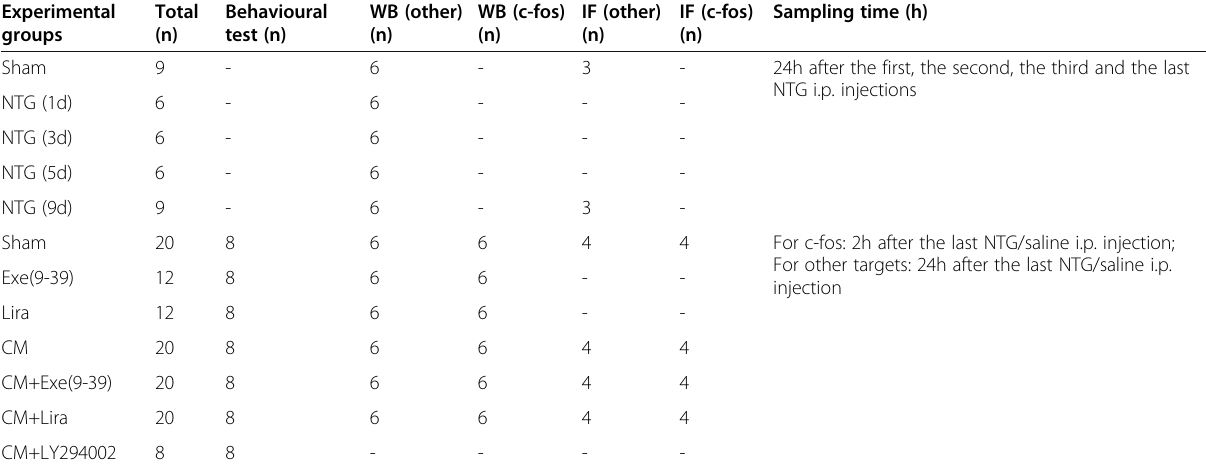
Table 1 Schematic representation of experimental groups, sample size (number, n) and the sampling time (hour, h) of mice per group for different experimental analysis Experimental